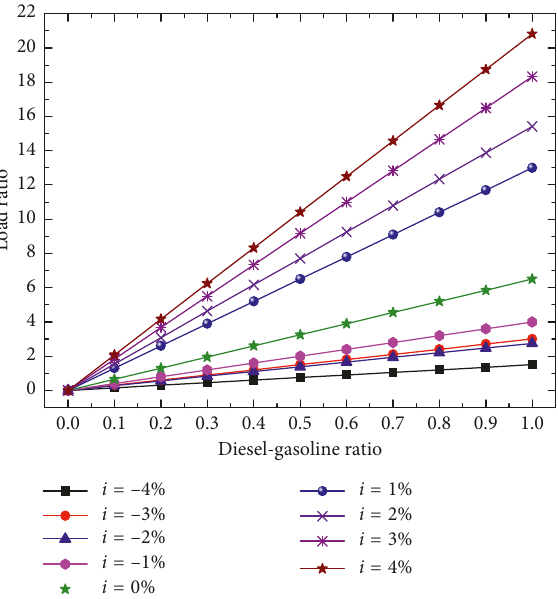
Figure 5: Load ratios changing with slope percent (80km/h, design